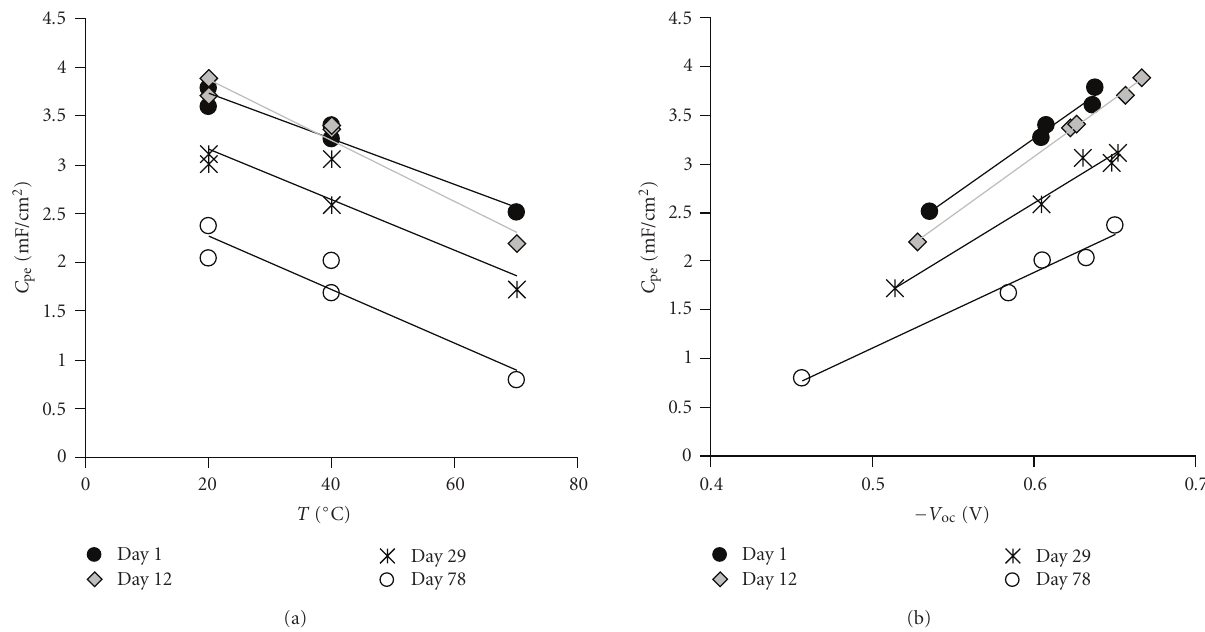
Figure 9: Photoelectrode capacitance as a function of temperature (a) and open circuit voltage (b); first set of EIS measurements.